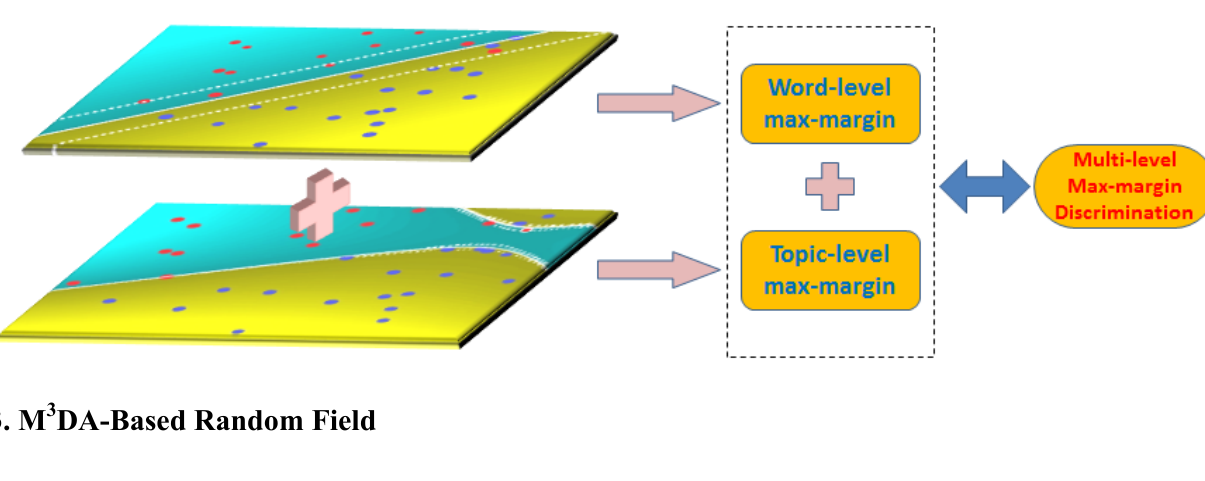
Figure 3. Schematic diagram of multi-level max-margin